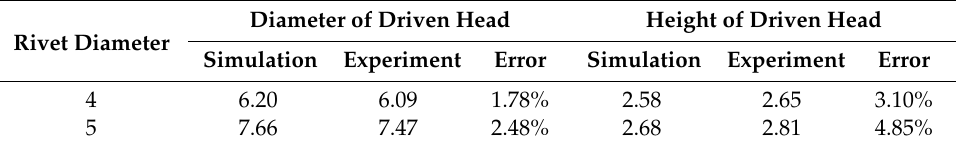
Table 6. The driven head geometries obtained from simulation results (unit: mm). Rivet Diameter